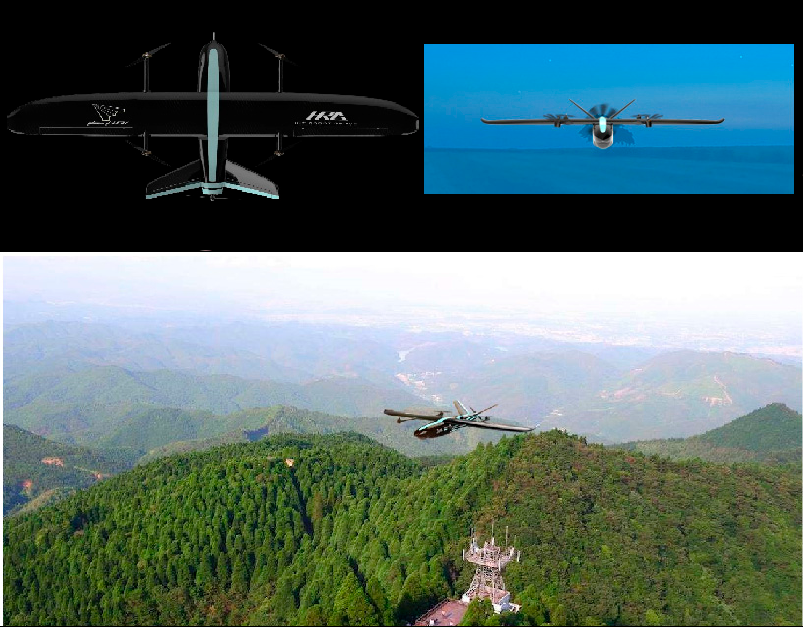
Figure 1. Forest Monitoring UAV PHECDA II developed by author of this paper. Table 1. Technical parameters of the forest monitoring UAV PHECDA II.